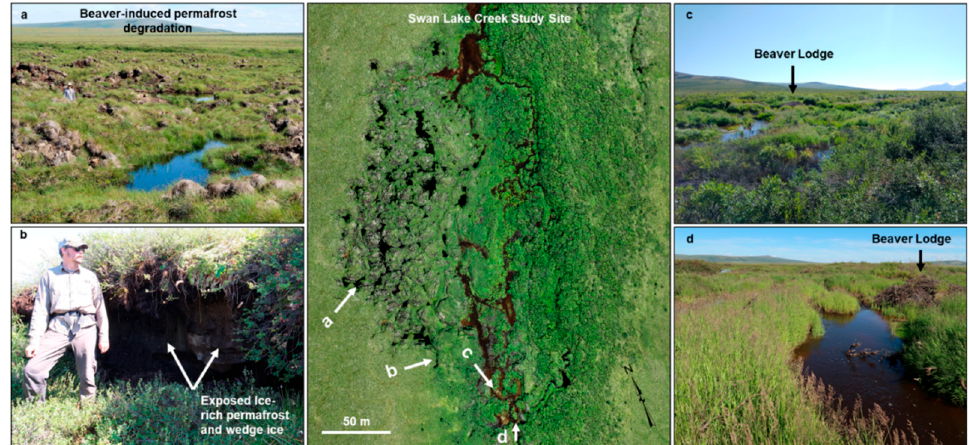
Figure 2. Field observations of the beaver-induced permafrost degradation feature at the Swan Lake Creek site in early August 2021. Vertical aerial image in the center derived from the UAS data collected on 6 August 2021. The location and view angle of the field photos shown in ( a – d ) are indicated with the corresponding letter and arrow. Field photos showing ( a ) thermokarst mounds and degraded ice wedges (photo K.D. Tape), ( b ) exposed ice-rich permafrost and wedge ice (photo K.D. Tape), ( c ) shrub vegetation in the creek valley with the beaver lodge in the middle of the image (photo A.C. Bondurant), and ( d ) the creek and beaver lodge looking downstream from just south of the beaver-induced permafrost degradation feature (photo K.D. Tape).